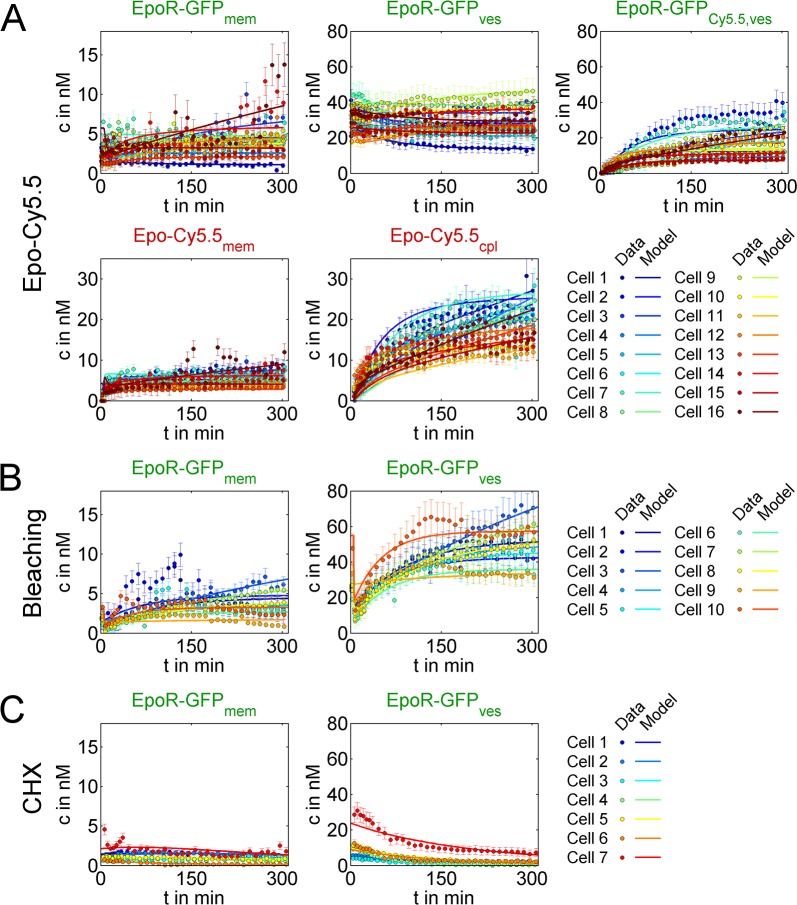
Fits of the optimal cell ensemble model variant to the complete dataset.(A) Fits of the model variant ACD to 16 Epo-Cy5.5 internalizing cells (circles, experimental data; lines, model fits; EpoR-GFPmem, membrane EpoR; EpoR-GFPves, EpoR in vesicles without Epo; EpoR-GFPCy5.5,ves, EpoR in Epo-Cy5.5 vesicles; Epo-Cy5.5mem, Epo-Cy5.5 bound to membrane EpoR; Epo-Cy5.5cpl, cytosolic Epo-Cy5.5). (B) ACD model fits to data from 10 cells newly synthesizing EpoR-GFP after bleaching at t = 5’ (EpoR-GFPmem, membrane EpoR; EpoR-GFPves, Epo in vesicles). (C) ACD model fits to data from 7 cells degrading EpoR-GFP after inhibiting synthesis with CHX as in (B).